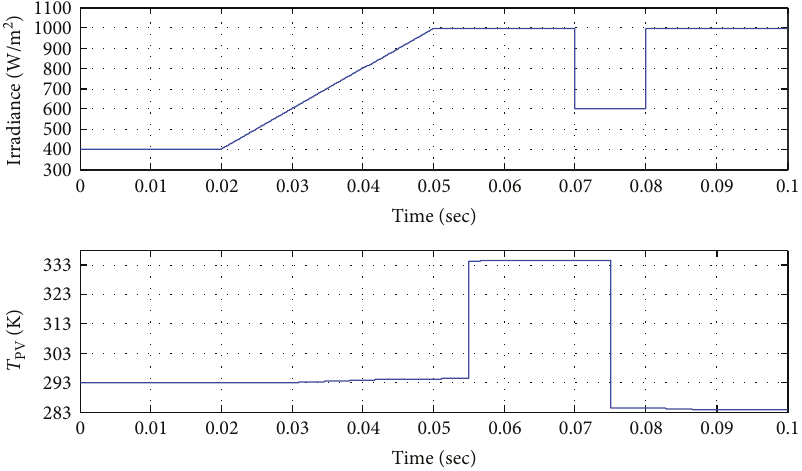
Figure 16: Changing the ambient